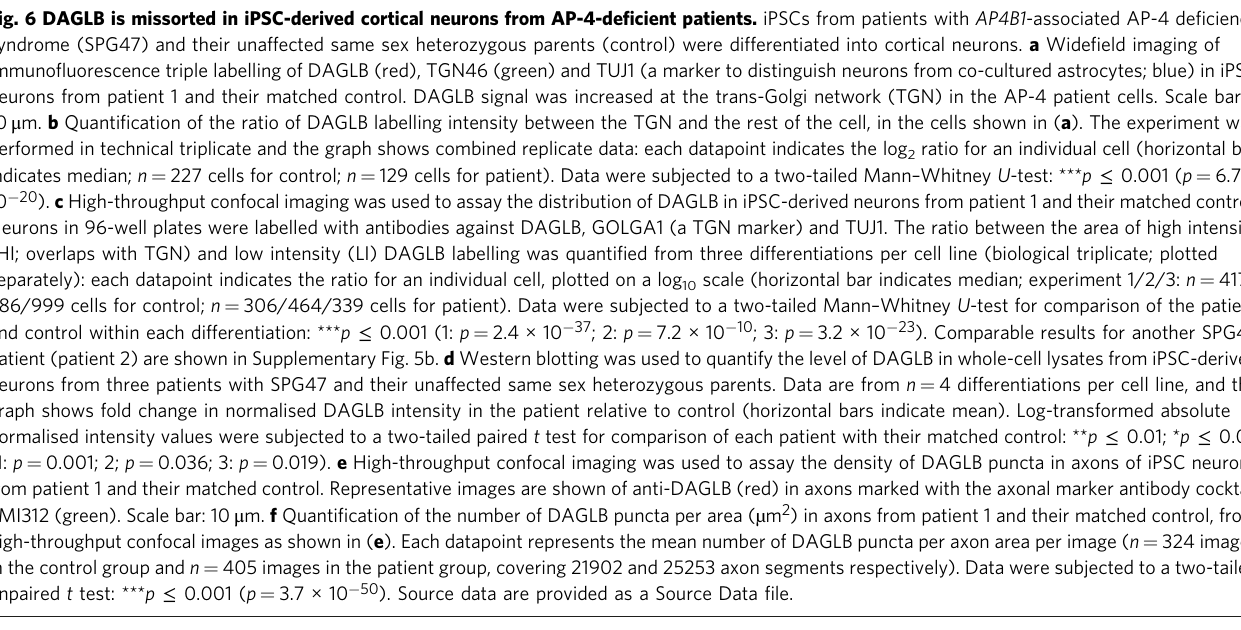
Fig. 6 DAGLB is missorted in iPSC-derived cortical neurons from AP-4-de fi cient patients. iPSCs from patients with AP4B1 -associated AP-4 de fi ciency syndrome (SPG47) and their unaffected same sex heterozygous parents (control) were differentiated into cortical neurons. a Wide fi eld imaging of immuno fl uorescence triple labelling of DAGLB (red), TGN46 (green) and TUJ1 (a marker to distinguish neurons from co-cultured astrocytes; blue) in iPSC neurons from patient 1 and their matched control. DAGLB signal was increased at the trans-Golgi network (TGN) in the AP-4 patient cells. Scale bar: 10 μ m. b Quanti fi cation of the ratio of DAGLB labelling intensity between the TGN and the rest of the cell, in the cells shown in ( a ). The experiment was performed in technical triplicate and the graph shows combined replicate data: each datapoint indicates the log 2 ratio for an individual cell (horizontal bar indicates median; n = 227 cells for control; n = 129 cells for patient). Data were subjected to a two-tailed Mann – Whitney U -test: *** p ≤ 0.001 ( p = 6.7 × 10 − 20 ). c High-throughput confocal imaging was used to assay the distribution of DAGLB in iPSC-derived neurons from patient 1 and their matched control. Neurons in 96-well plates were labelled with antibodies against DAGLB, GOLGA1 (a TGN marker) and TUJ1. The ratio between the area of high intensity (HI; overlaps with TGN) and low intensity (LI) DAGLB labelling was quanti fi ed from three differentiations per cell line (biological triplicate; plotted separately): each datapoint indicates the ratio for an individual cell, plotted on a log 10 scale (horizontal bar indicates median; experiment 1/2/3: n = 417/ 786/999 cells for control; n = 306/464/339 cells for patient). Data were subjected to a two-tailed Mann – Whitney U -test for comparison of the patient and control within each differentiation: *** p ≤ 0.001 (1: p = 2.4 × 10 − 37 ; 2: p = 7.2 × 10 − 10 ; 3: p = 3.2 × 10 − 23 ). Comparable results for another SPG47 patient (patient 2) are shown in Supplementary Fig. 5b. d Western blotting was used to quantify the level of DAGLB in whole-cell lysates from iPSC-derived neurons from three patients with SPG47 and their unaffected same sex heterozygous parents. Data are from n = 4 differentiations per cell line, and the graph shows fold change in normalised DAGLB intensity in the patient relative to control (horizontal bars indicate mean). Log-transformed absolute normalised intensity values were subjected to a two-tailed paired t test for comparison of each patient with their matched control: ** p ≤ 0.01; * p ≤ 0.05 (1: p = 0.001; 2; p = 0.036; 3: p = 0.019). e High-throughput confocal imaging was used to assay the density of DAGLB puncta in axons of iPSC neurons from patient 1 and their matched control. Representative images are shown of anti-DAGLB (red) in axons marked with the axonal marker antibody cocktail SMI312 (green). Scale bar: 10 μ m. f Quanti fi cation of the number of DAGLB puncta per area ( µ m 2 ) in axons from patient 1 and their matched control, from high-throughput confocal images as shown in ( e ). Each datapoint represents the mean number of DAGLB puncta per axon area per image ( n = 324 images in the control group and n = 405 images in the patient group, covering 21902 and 25253 axon segments respectively). Data were subjected to a